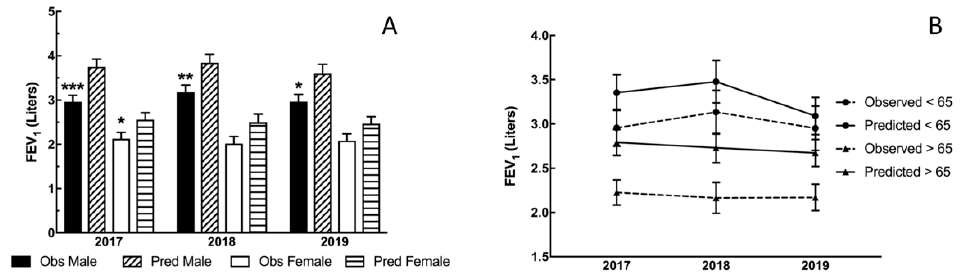
Figure 5. Annual changes between sex ( A ) and age ( B ) in FEV 1 in the Seeley Lake Cohort. Changes to FEV 1 from predicted values. The graph in panel A depicts the deviations from predicted of observed FEV 1 values in 2017, 2018, and 2019 following the Rice Ridge fire in Seeley Lake, MT. In all three assessments following the exposure the observed FEV 1 values were lower than predicted based on age, sex, race, and height (NHANES III–Hankinson 1999), and significantly lower all years for males and in 2017 for female participants. In addition, the male values were significantly lower as compared to the observed values in 2017. (** p < 0.01; *** p < 0.001 Observed vs. Predicted within Sex). The effect of age on FEV 1 changes is in panel B. The observed FEV 1 values versus the predicted FEV 1 for the Seeley Lake, MT cohort for the three visits (over two years) following the wildfires. The two groups depicted in the graph above are categorized as either > 65 years old or < 65 years old. All FEV 1 values were analyzed on individual parameters (age, sex, height) for each year. Both sets showed decreased, compared with predicted values, FEV 1 values. The younger group ( < 65 years) was not significantly lower and appears to approach predicted levels by the second year after the fires; while the older ( > 65 years) group remained significantly lower observed values for the > 65 group (* p < 0.05).